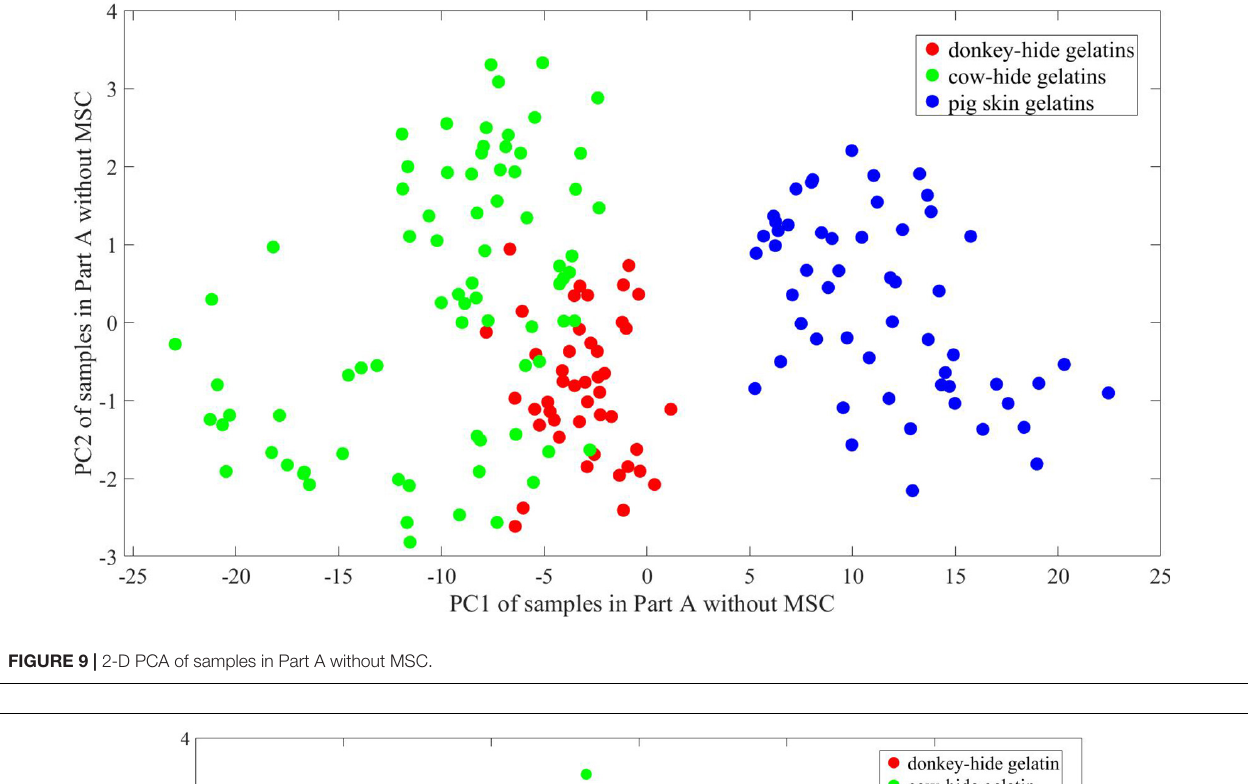
FIGURE 9 | 2-D PCA of samples in Part A without MSC.